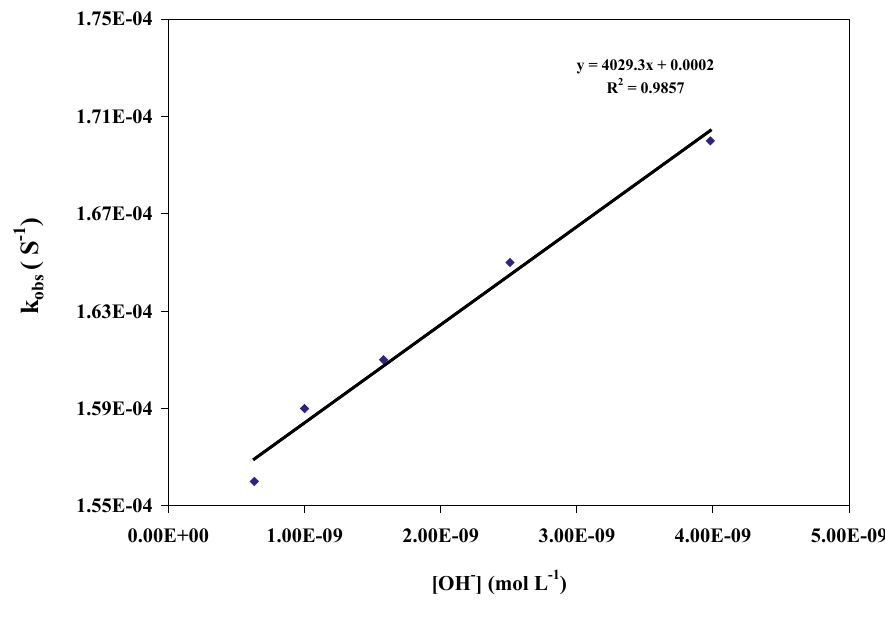
Figure 2. Effect of OH- concentration on k